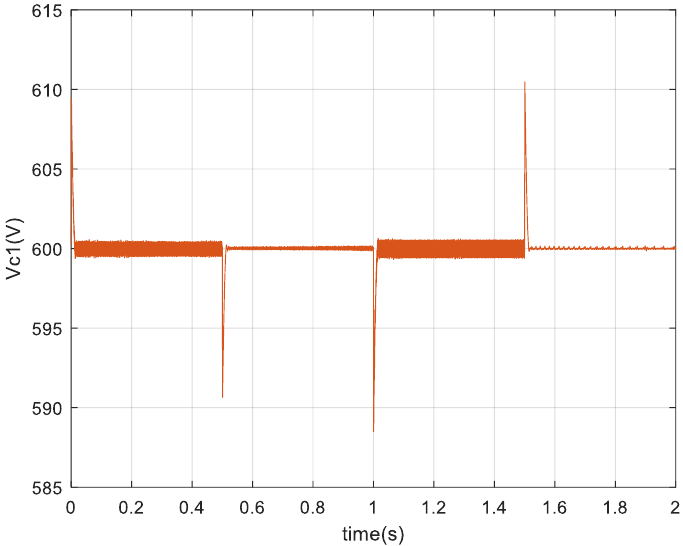
Figure 11. Simulation result of bus voltage under proposed control method.